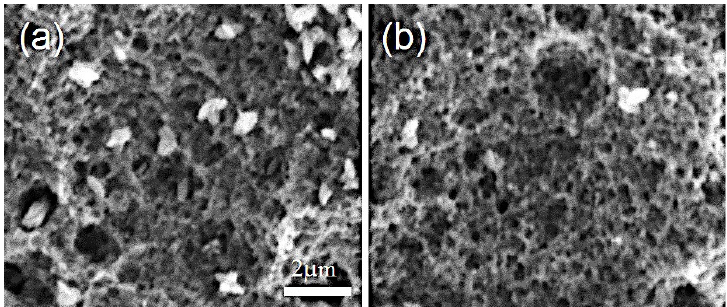
Figure 2. Close up SEM images from Figure 1 (captured from the images at the magnification of 2000× under SEM). ( a ) Group HF; and ( b ) Group GBHF. Note the sharp spikes of the surface.